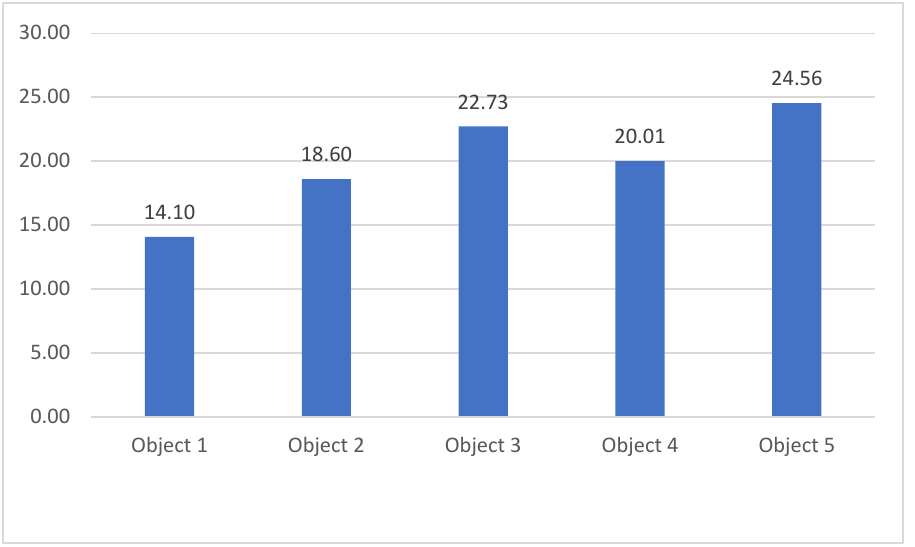
Figure 3 . Yield of large potato tubers t·ha -1 (on average for two cultivars Oberon and Malaga and three study years 2018-2020).